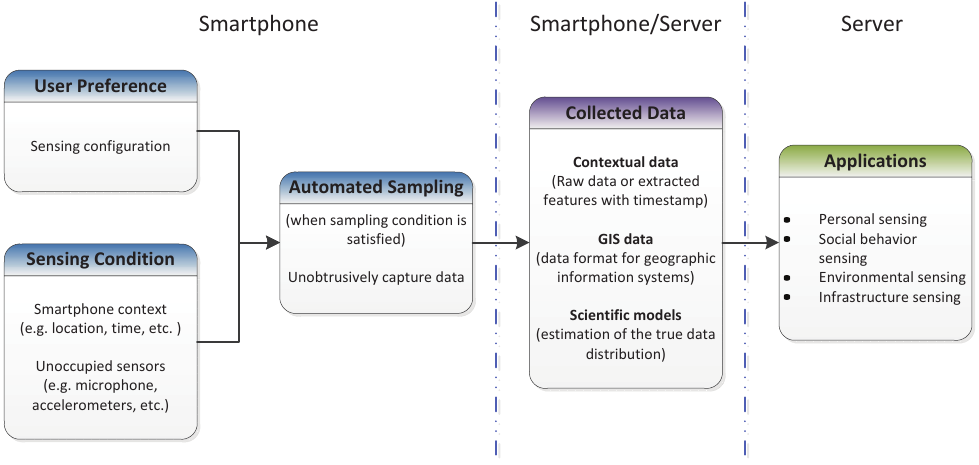
Figure 2. Common architecture for opportunistic